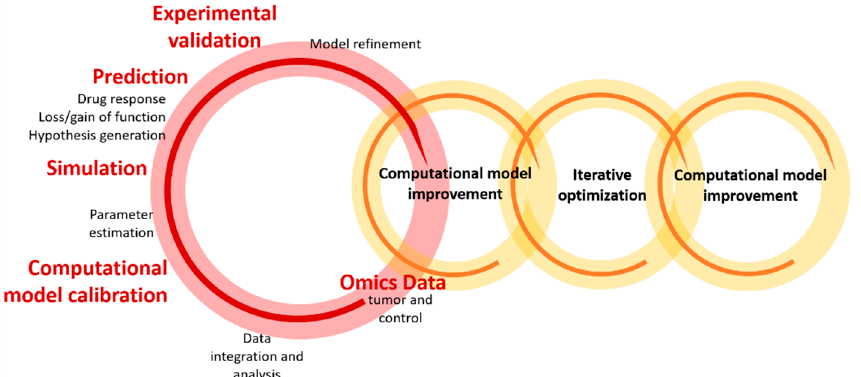
Figure 2. Schematic representation of the iterative optimization workflow, reflecting the data integration/analysis and the development/optimization processes of the computational model.